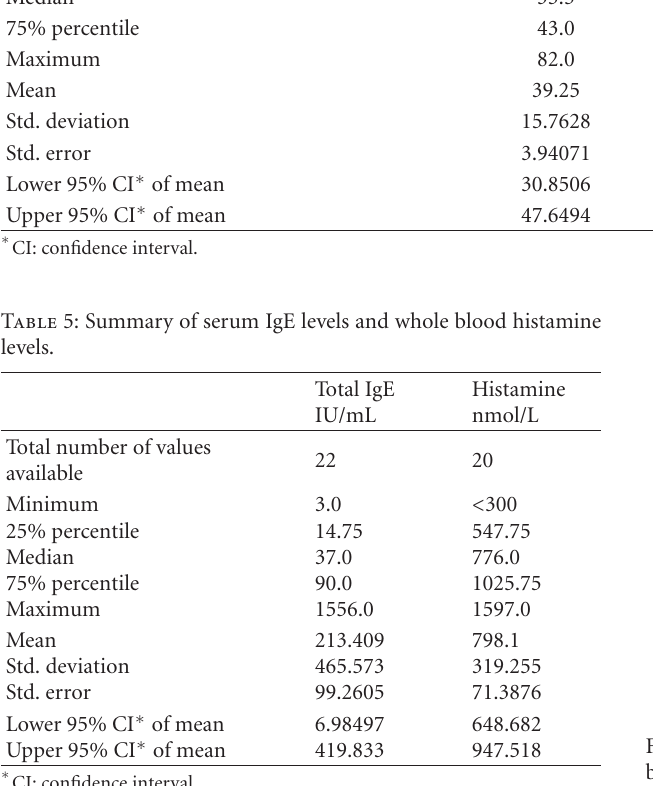
serum IgE levels or whole-blood histamine levels greater than 300 nmol/L [24, 25, 30]. The corresponding plasma histamine level would be 3 nmol/L